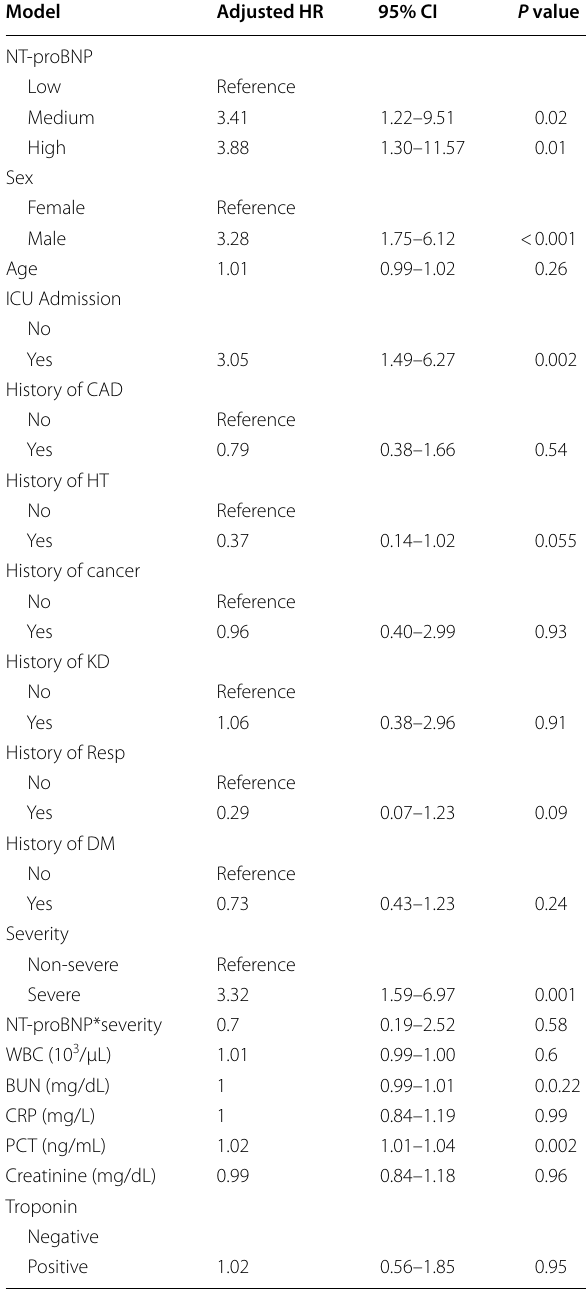
Table 5 Adjusted effect of NT-proBNP on in-hospital death of patients with COVID-19 estimated through Cox proportional– hazard regression